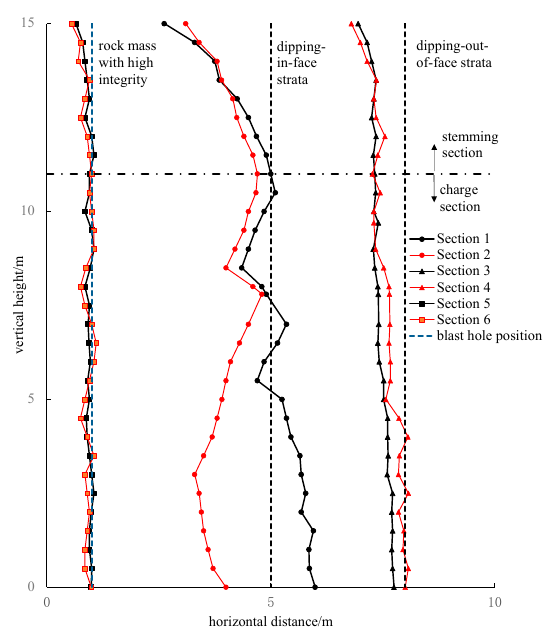
Figure 12. The shape of the free face after blasting in different inclined strata.